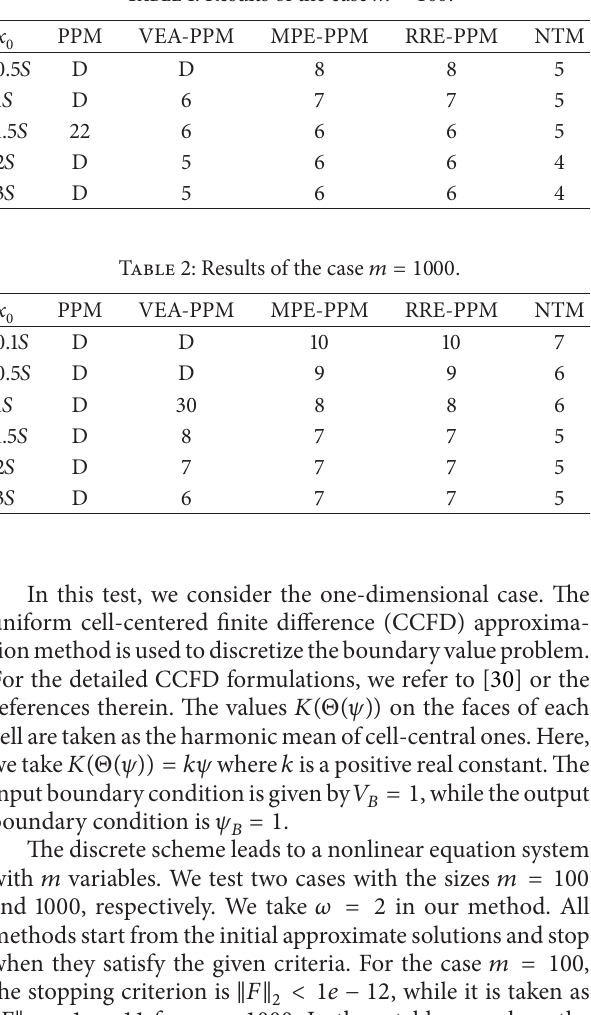
Table 1: Results of the case 𝑚 = 100 .